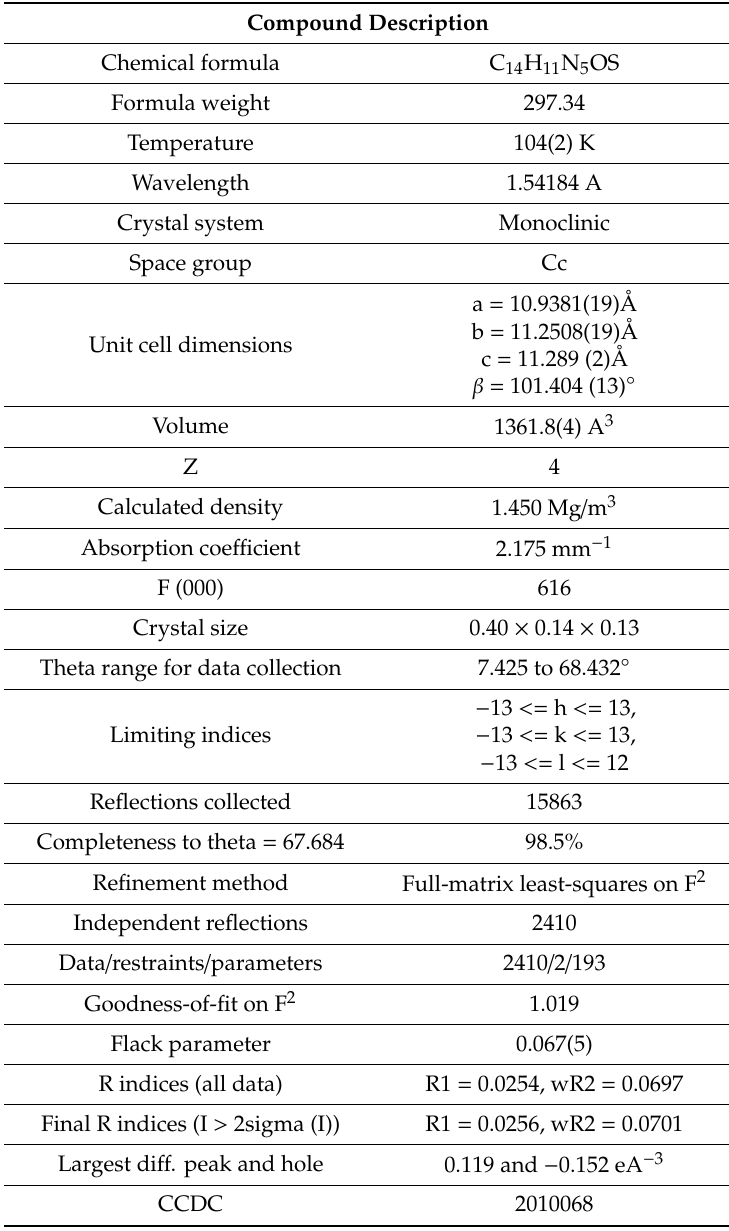
Table 1. Experimental crystal dataset of the target